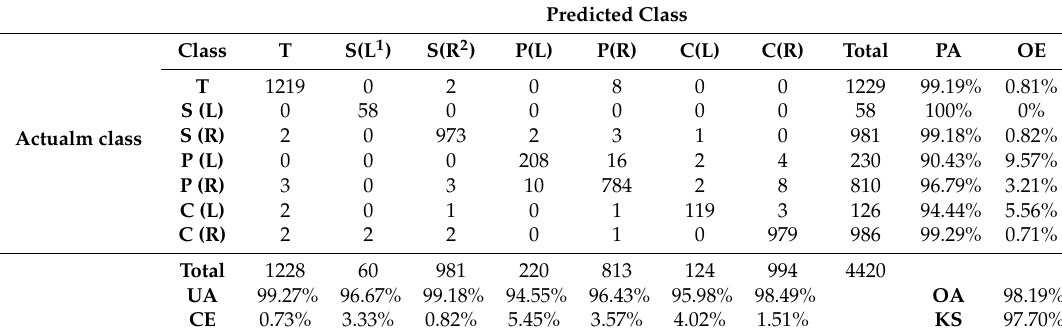
Table 4. Confusion matrix of pose recognition with seven